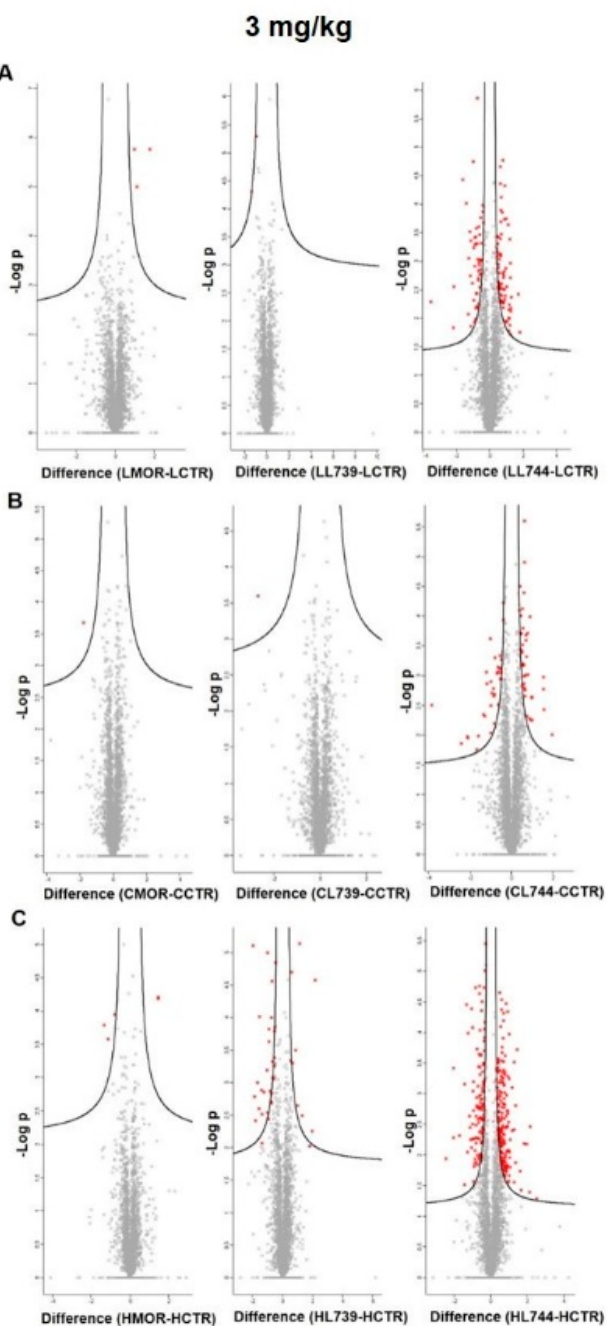
Figure 2. Volcano plots indicating significantly altered proteins identified in rat spleen lymphocytes ( A ), brain cortex ( B ), and hippocampus ( C ) after 7-day treatment with 3 mg/kg of morphine ( MOR , left panels), LYS739 ( middle panels), and LYS744 ( right panels). Significantly altered proteins are labeled in red (the star symbols); performed with Perseus software version 1.6.15.0. L739, LYS739 ; L744, LYS744 . The effect of 7-day morphine treatment (3 mg/kg) on protein alterations in the rat brain cortex was slightly less than that detected in the proteome profile of spleen lym- and 10 proteins were downregulated, Table S1b. From the functional point of view, 3